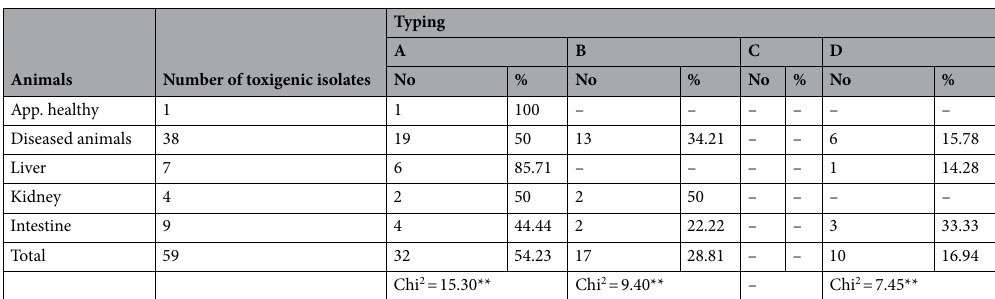
Table 2. Typing of Clostridium perfringens isolate in guinea pigs. ** = Significant at ( P < 0.01).